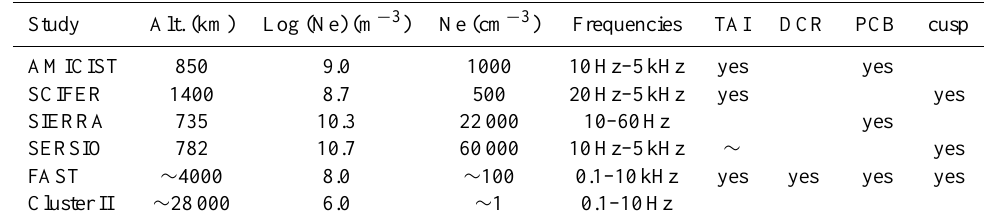
Table 2. Summary of the observations of BBELF and their occurrence with transversely accelerated ions, downward current regions, polar cap boundary regions, and the cusp region. Study Alt. (km) Log (Ne) (m − 3 ) Ne (cm − 3 ) Frequencies TAI DCR PCB cusp AMICIST 850 9.0 1000 10Hz–5kHz SCIFER 1400 SIERRA ∼